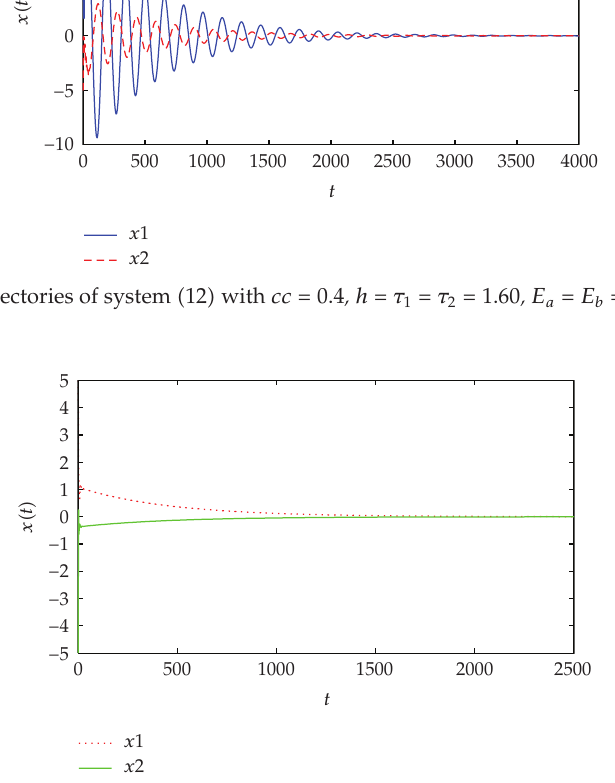
Figure 2: State trajectories of system (cid:2) 12 (cid:3) with cc (cid:9) 0 . 4 , τ 1 (cid:9) τ 2 (cid:9) 0 . 3 , h (cid:9) 1 . 94 , E a (cid:9) E b (cid:9) E d (cid:9) 0 . 2 I,K (cid:9) I.